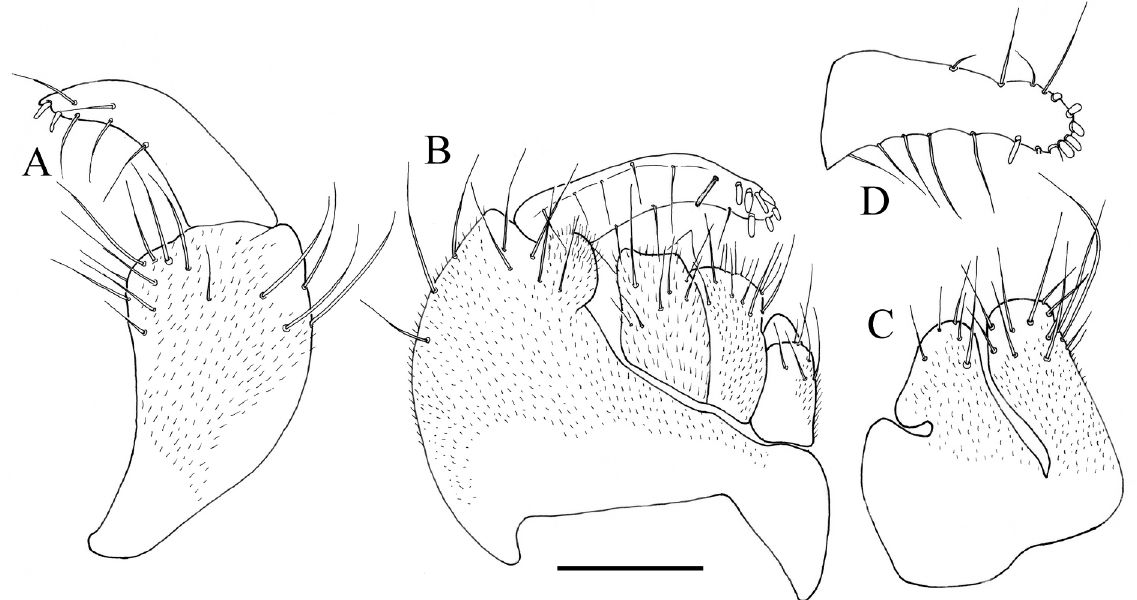
Fig. 6. Terminalia of Tachydromia iberica (Arias, 1919) from Spain, Madrid (RBINS). A . Right surstylus and right epandrial lamella. B . Epandrium with cerci. C . Left epandrial lamella and left surstylus. D . Right surstylus. Scale bar: 0.1